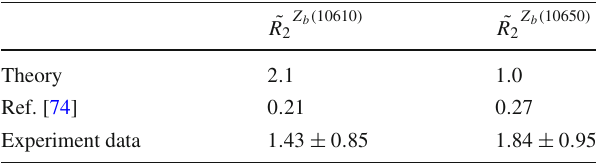
Table 6 The P-wave decay ratios when the r 0 is 1 . 6 fm. The experi- mental data comes from Ref.